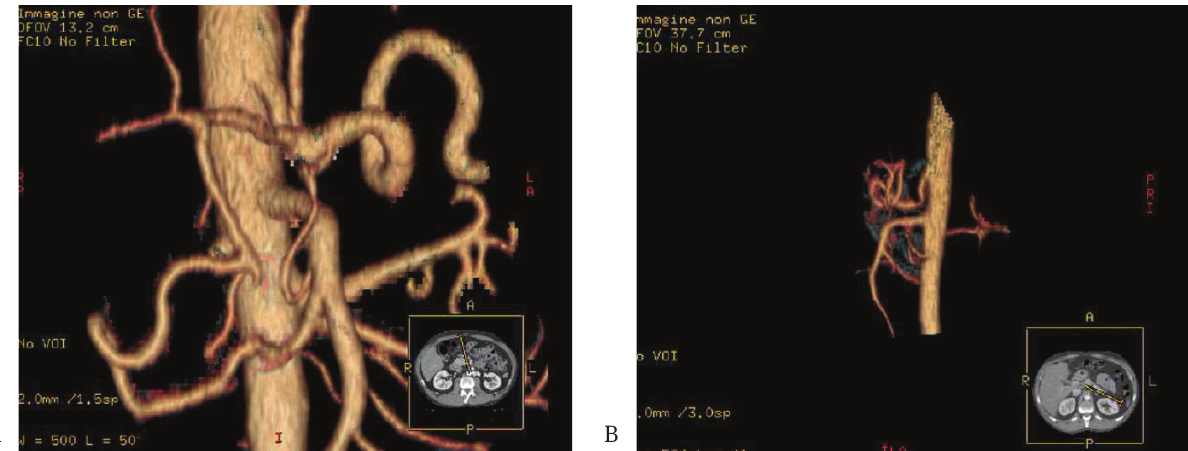
Figure 2 a-b: Pre operative angio CT Scan: The images series showed an inversion blood flow through the pancreaticoduodenal arteries became